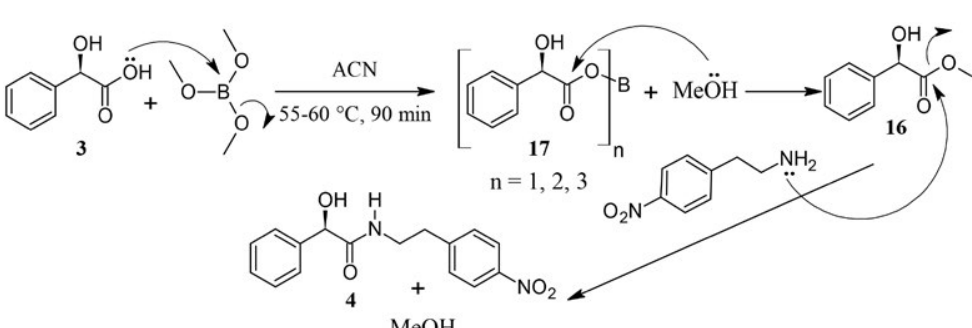
mediated synthesis of amide 4 3